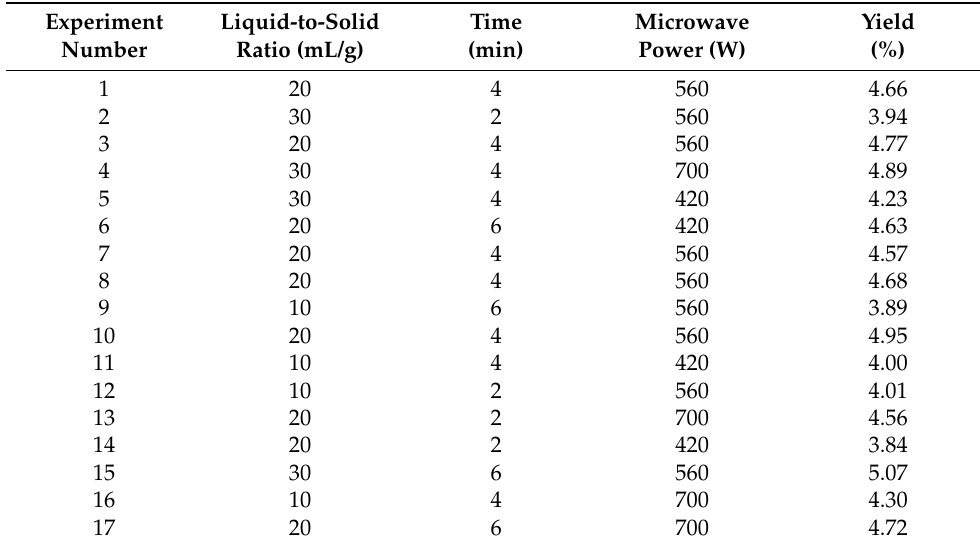
Table 2. Design and results of response surface methodology.